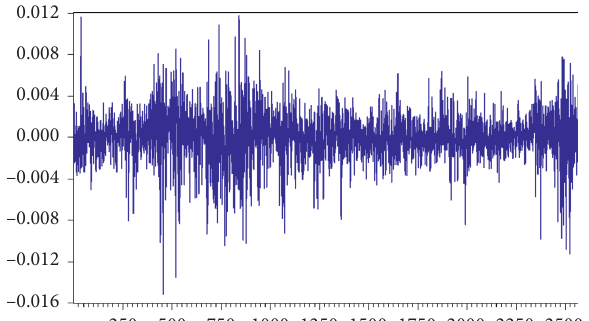
Figure 6: Trend chart of the CSI 300 index yield rate